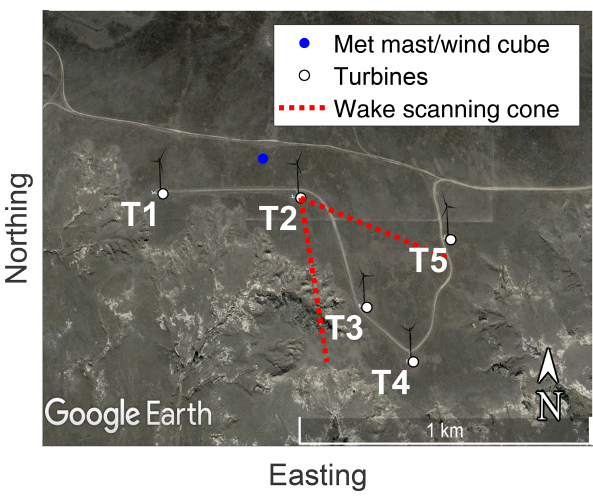
Figure 1. Overview of the measurement site and set-up (© Google Earth). Shown in white are the five turbines of the local cluster, with the remainder of the wind park to the east. Turbine 2 (T2) was pro- grammed to introduce a yaw offset if turbine 3 (T3) was downwind. The distance between T2 and T3 is approximately 390m. T2 had two Doppler lidars installed on the nacelle to scan the inflow and the wake (Sect. 2.2.2 and 2.2.4). Shown in red is the scanning cone of the wake-scanning Doppler lidar for a case with the wind direc- tion aligned with the direction to T3 and a yaw angle of 20 ◦ . Shown in blue is the location of the meteorological mast and the WindCube (Sect. 2.2.3 and